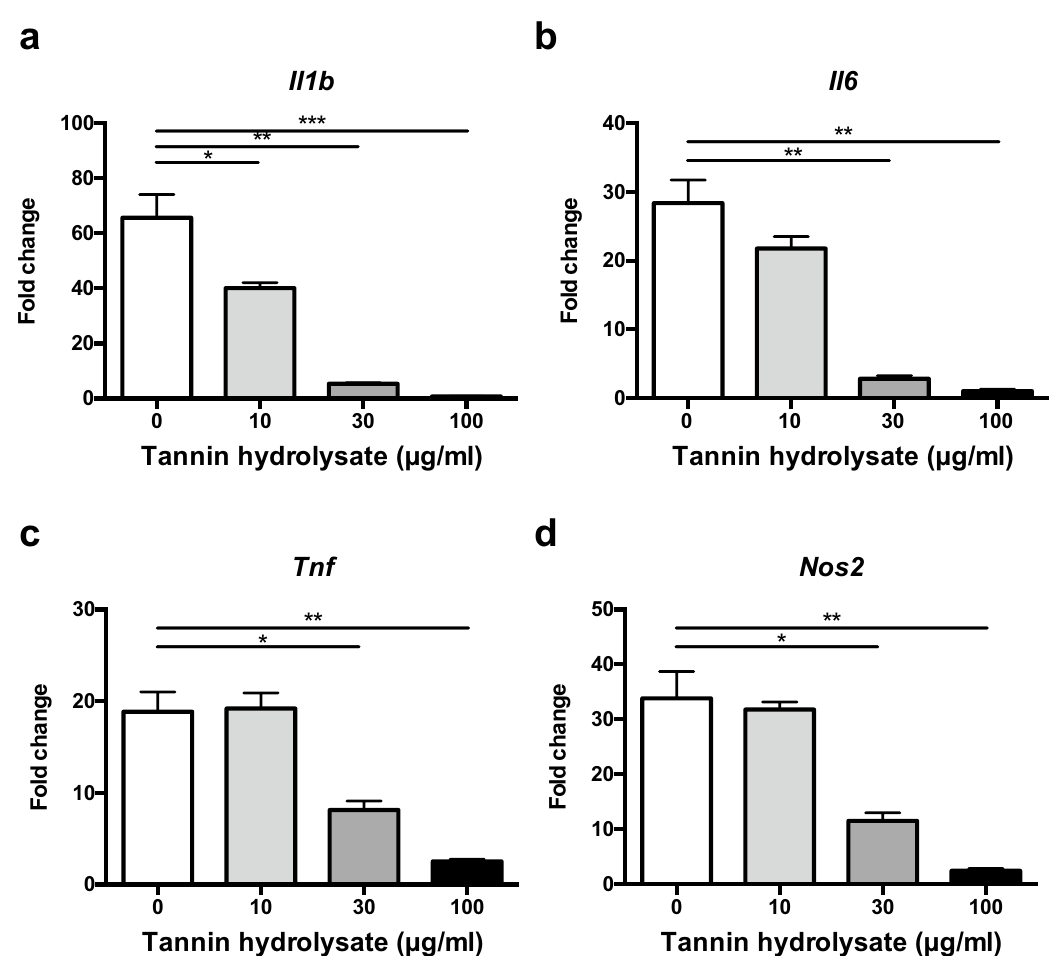
Figure 3. Hydrolysate of tannin suppresses induction of inflammatory genes in stimulated macrophages in vitro. BMMCs were pretreated with tannin hydrolysate at 0–100 µg/ml for 2 h and then stimulated with TLR9 ligand CpG DNA for 4 h. Expression of inflammatory genes IL-1β ( a ), IL-6 ( b ), TNF-α ( c ), and iNOS (d) was measured by quantitative PCR. Data are shown as the mean ± SEM (n = 3). * p < 0.05, ** p < 0.01, *** p < 0.001 compared with no treatment with tannin hydrolysate (0